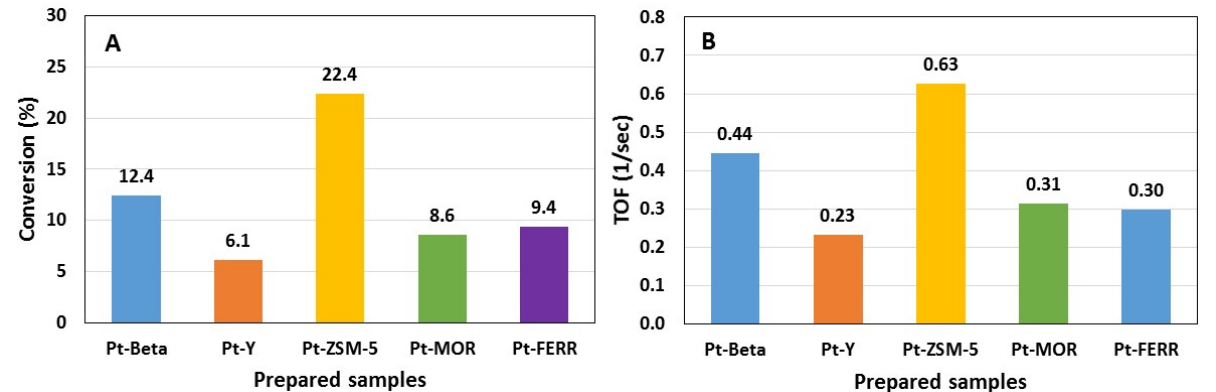
Figure 8. ( A ) The obtained conversion (%) of cyclohexene over Pt-incorporated zeolite materials (Beta, Y, ZSM-5, MOR, and FERR). ( B ) The corresponding TOF.